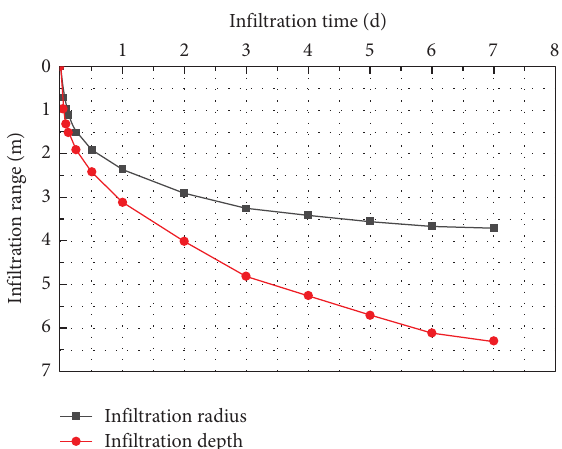
Figure 7: Relation curve of infiltration depth, infiltration radius, and infiltration time.